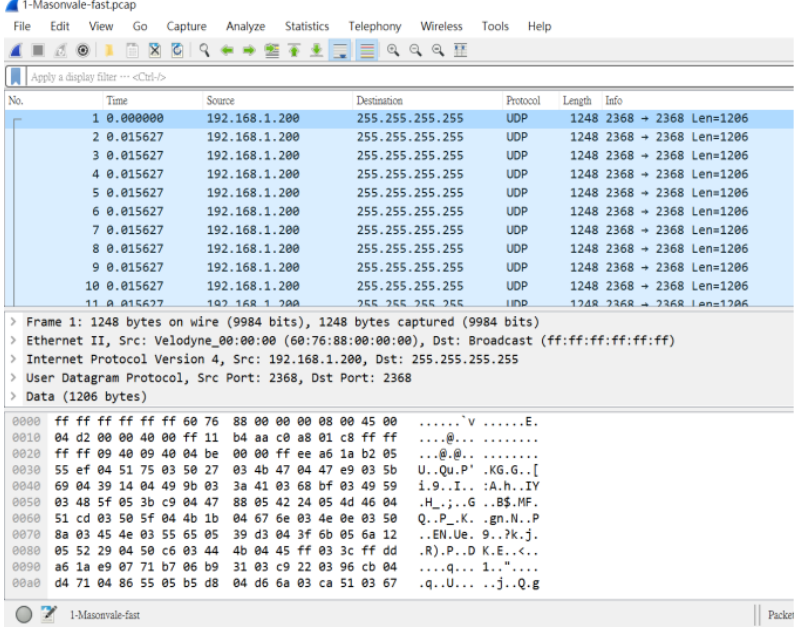
Figure 4. Wireshark software environment.